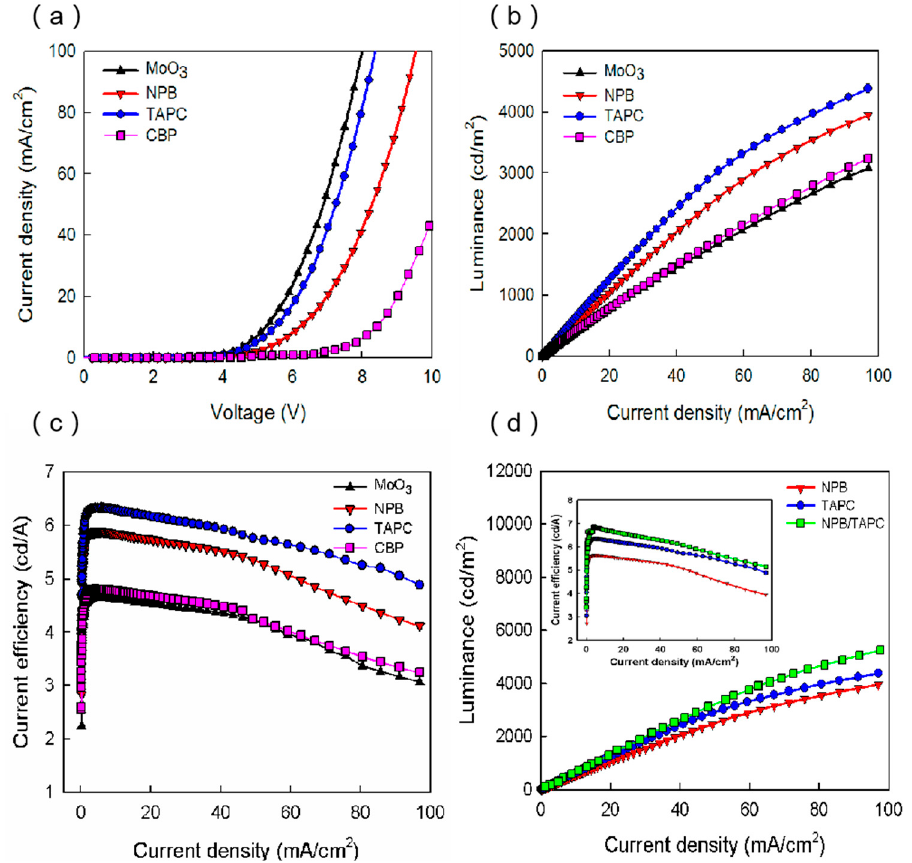
Figure 2. ( a ) Current density versus voltage curves, ( b ) luminance versus current density curves, ( c ) ( a ) Current density versus voltage curves, ( b ) luminance versus current current efficiency versus current density curves of blue OLEDs with 2,2',2"-(1,3,5-Benzinetriyl)-tris(1- density curves, ( c ) current e ffi ciency versus current density curves of blue OLEDs with phenyl-1-H-benzimidazole) (TPBi) electron transport layers (ETL) and four different hole transport 2,2’,2”-(1,3,5-Benzinetriyl)-tris(1-phenyl-1-H-benzimidazole) (TPBi) electron transport layers (ETL) layers (HTLs). ( d ) Luminance versus current density curves of blue OLEDs with TPBi ETL and N,N’-Di(1- and four di ff erent hole transport layers (HTLs). ( d ) Luminance versus current density curves of naphthyl)-N,N’-diphenyl-(1,1’-biphenyl)-4’-diamine (NPB), 1,1-Bis[(di-4-tolylamino)phenyl]cyclohexane blue OLEDs with TPBi ETL and N,N’-Di(1-naphthyl)-N,N’-diphenyl-(1,1’-biphenyl)-4’-diamine (NPB), (TAPC), NPB/TAPC HTLs. 1,1-Bis[(di-4-tolylamino)phenyl]cyclohexane (TAPC), NPB / TAPC